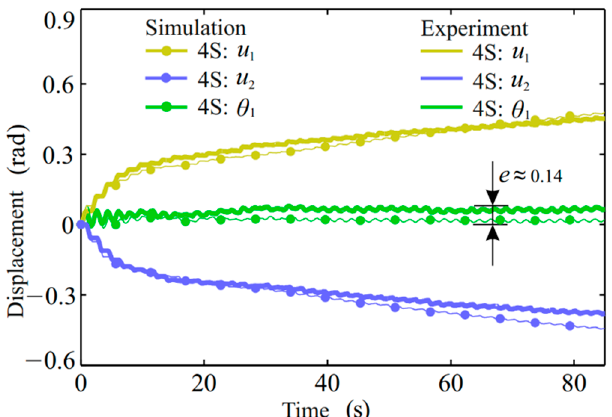
Figure 9. Experimental and simulation responses of the 4S under harmonic disturbance, here 𝑀(cid:3553) (cid:2914) = 0.05Nm , 𝜂 (cid:2929) = 100 , and 𝜂 (cid:2914) = 3 . Solid bold line: experiment results; point-solid line: simulation; yel- (cid:98) M d = 0.05 Nm, η s = 100, and η d = 3. Solid bold line: experiment results; point-solid line: low: deformation of spring 1, 𝑢 (cid:2869) ; blue: deformation of spring 2, 𝑢 (cid:2870) ; green: position of primary plate, simulation; yellow: deformation of spring 1, u 1 ; blue: deformation of spring 2, u 2 ; green: position of 𝜃 (cid:2869) . primary plate, θ 1